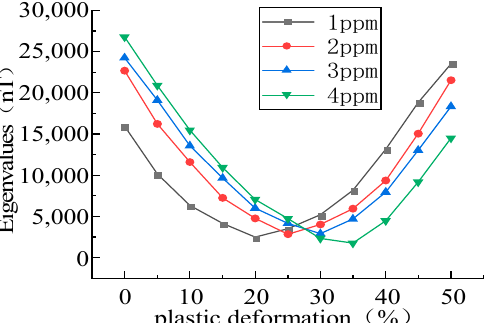
Figure 11. Positional relationship between magnetostriction and inflection point .